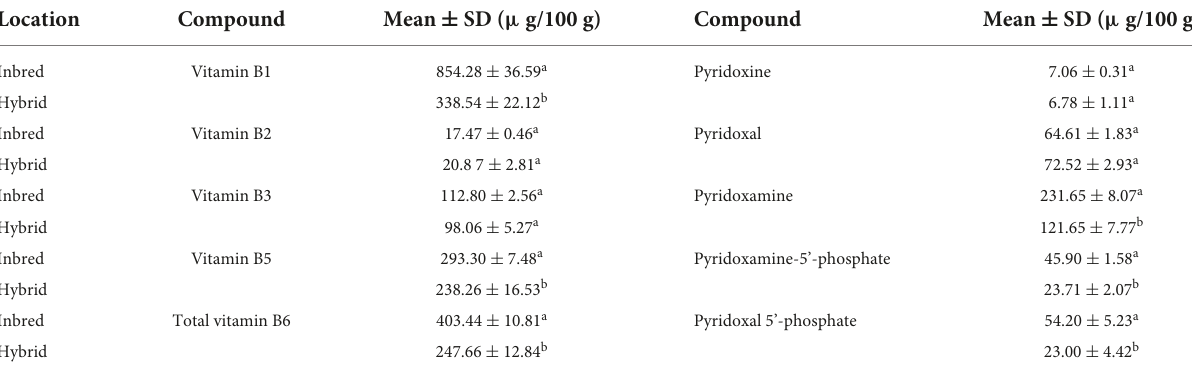
TABLE 2 Mean comparisons of vitamin B1, B2, B3, B5, and total B6, and the derivatives of B6 contents between inbred and commercial hybrid lines in Hebei.